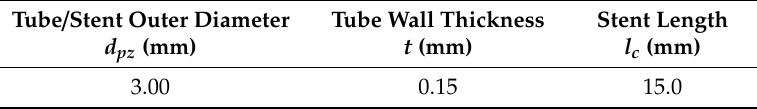
Table 6. Specimen nominal dimensions.